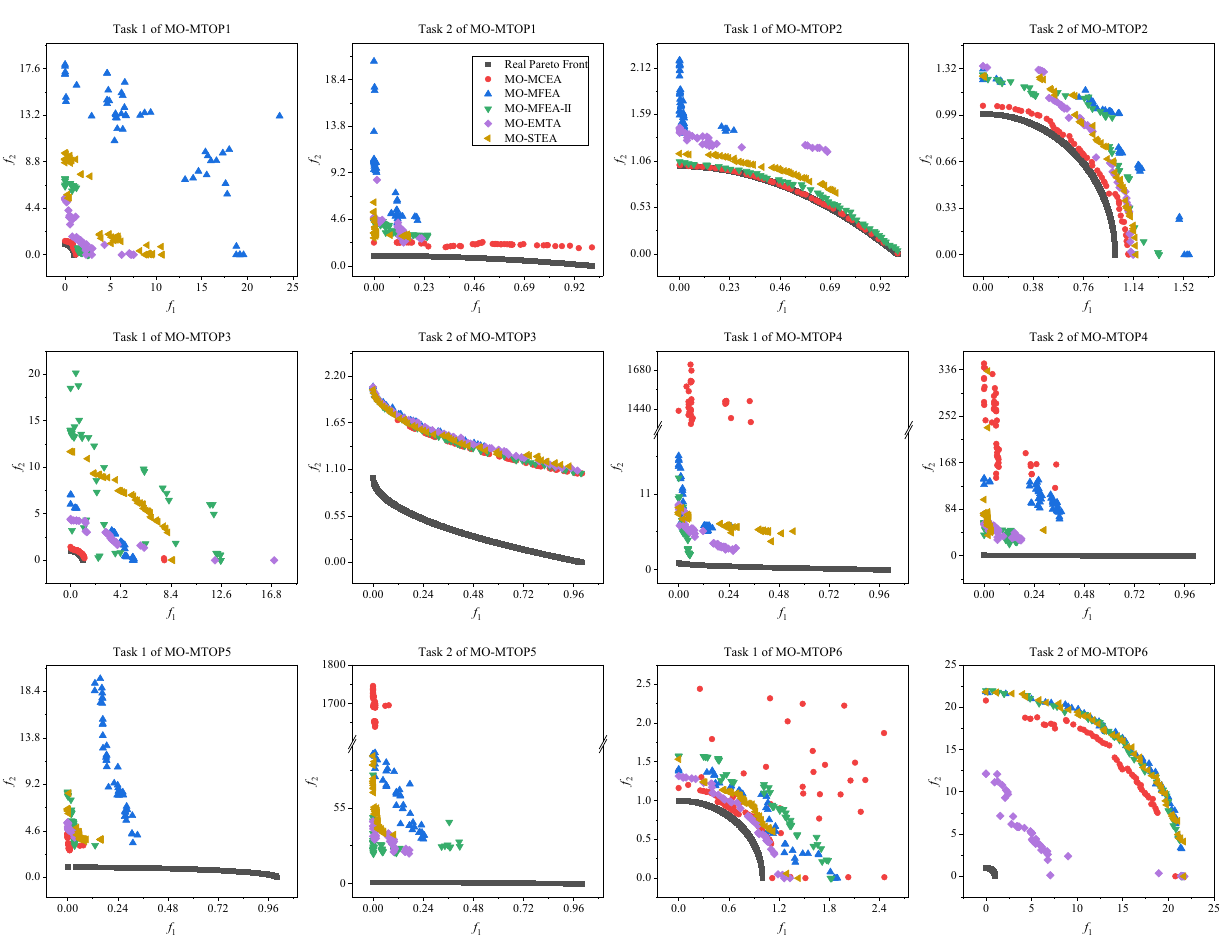
Fig. 3 Plots of solutions found by different algorithms on the multi-objective tasks of different problems